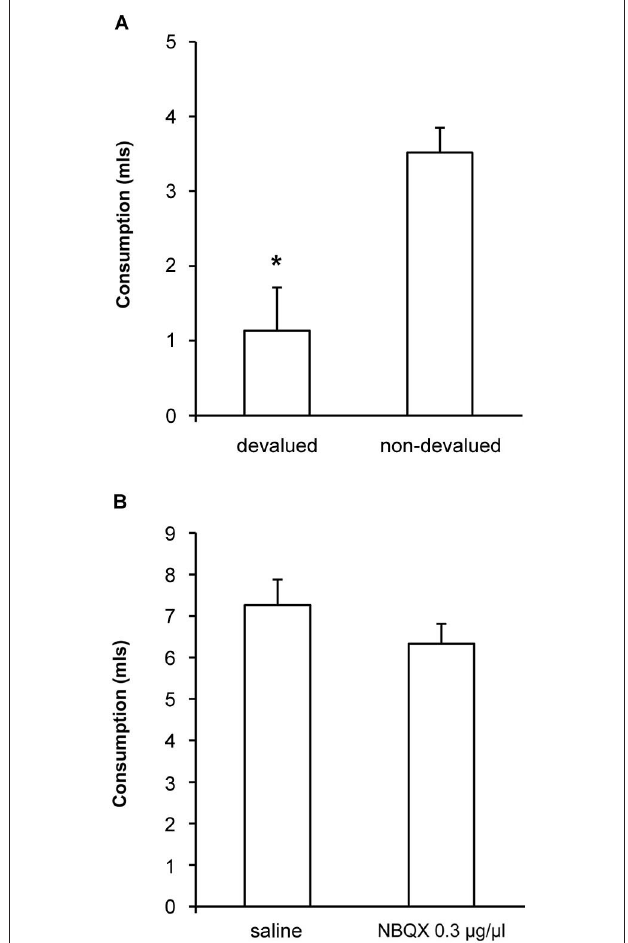
FIGURE 4 | Effects of NBQX on sensitivity of consumption to outcome devaluation and on home cage drinking . (A) When consumption of ethanol following pre-feeding of ethanol (devalued) or sucrose (non-devalued) was measured, a significant devaluation was detected demonstrating that the specific satiety treatment itself was effective but that this change in outcome value was not translated into lever-press performance under control conditions (see saline condition in Figure 3 ). (B) Ethanol consumption in the home cage following infusion of either saline or 0.3 µ g/ µ l NBQX was equivalent indicating that NBQX treatment itself did not somehow change the rats’ willingness to consume ethanol. * indicates p <